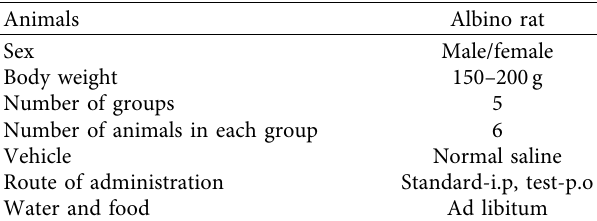
Table 2: Material and method: chemical induced writhing method. Animal